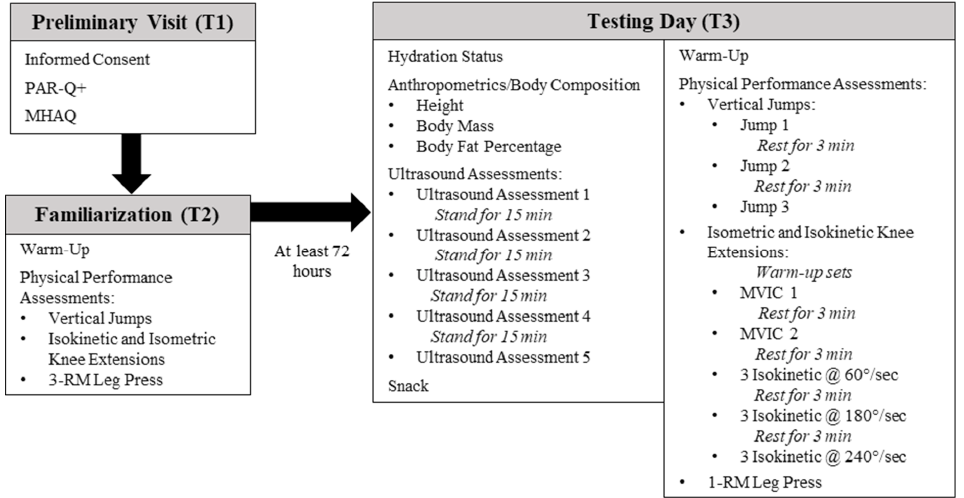
Figure 1. Timeline of study procedures. PAR-Q+: Physical activity readiness questionnaire;